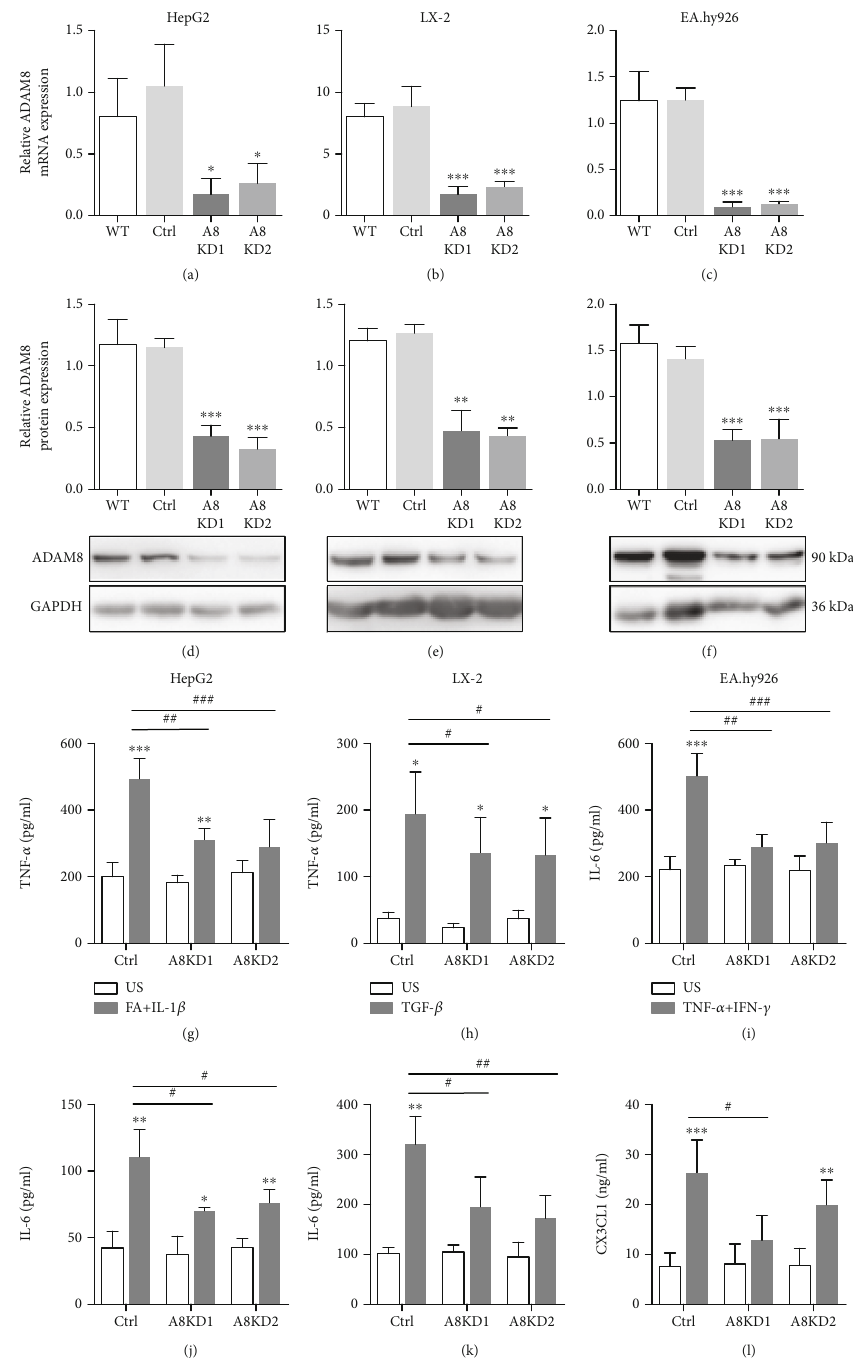
Figure 7: Downregulation of cytokine and chemokine release by ADAM8 knockdown. (a – f) The indicated types of human liver cells were left untransduced or transduced with lentiviruses coding for two di ff erent sequences of shRNA against ADAM8 expression (A8KD1 and A8KD2) or with control shRNA (Ctrl) to knockdown the ADAM8 expression. After 72 h, knockdown of ADAM8 was controlled on mRNA (a – c) and protein level (d – f). ADAM8 mRNA expression was quanti fi ed by qPCR and normalised to the expression of GAPDH for human cells. ADAM8 protein was detected by Western blot analysis and shown as representative blot for each cell line (d – f). The band intensities were quanti fi ed by densitometry and normalised to that of GAPDH. (g – l) The indicated types of cells with or without ADAM8 knockdown were left unstimulated (US) or stimulated with the indicated mediators. After 24 h, concentrations of released cytokines (TNF- α and IL-6) and chemokines (CX3CL1) in the supernatants were determined by ELISA. Quantitative data are shown as the mean + SD of 3-4 independent experiments, and representative Western blots are shown. Signi fi cant di ff erences caused by cell stimulation are indicated by asterisks ( ∗ p < 0 : 05 , ∗∗ p < 0 : 01 , and ∗∗∗ p < 0 : 001 ), and di ff erences caused by knockdown of ADAM8 compared to control are indicated by hashtags ( # p < 0 : 05 , ## p < 0 : 01 , and ### p < 0 : 001